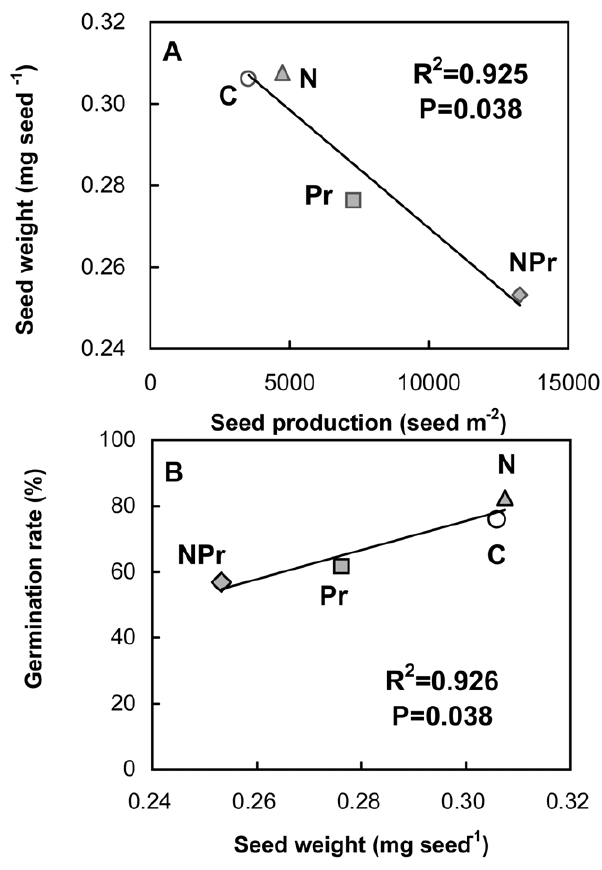
Figure 7. Effects of offspring-treatments on seedling biomass (g). The seedlings were germinated by seeds collected from the maternal control treatment. Data are mean 6 SE (n=7). See Figure 1 for